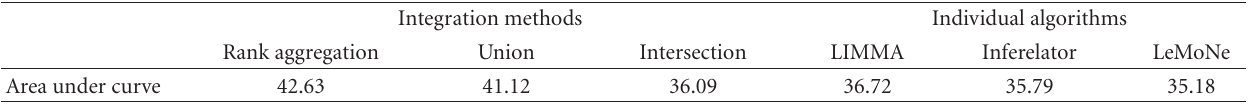
Table 4: Comparison of areas under precision curves for the top 100 predictions given by the integration methods and individual learning algorithms. The precision curves for the integration methods are shown in Figure 5, while the precision curves for the individual learning algorithms are shown in Figure